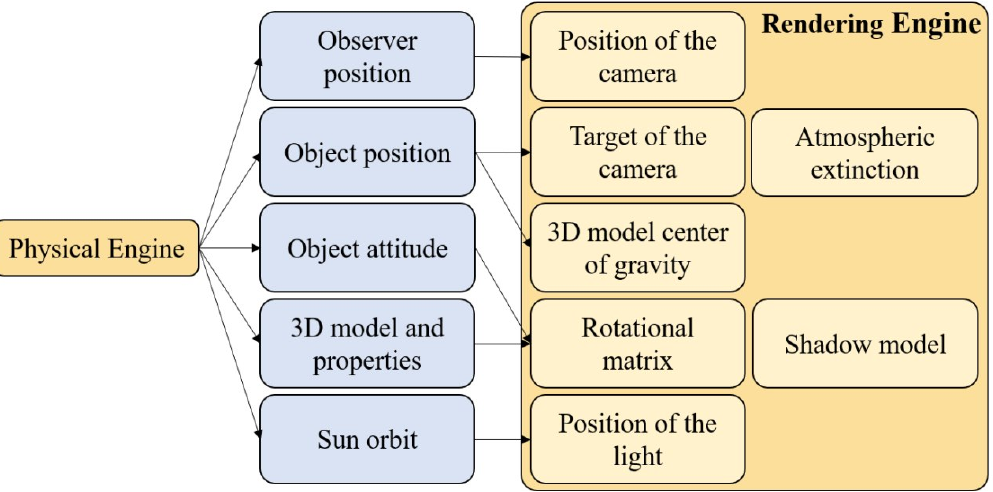
Figure 18. Rendering Engine—this engine takes care of computing, for each time step, the synthetic image of the object. The position of the observer is used as the position of the camera. The position of the object is used by the engine as the target of the barycenter of the 3D model to be rendered; the attitude of the object is then used to compute the rotation matrix of the model; finally, the position of the sun is used as the position of the light in the rendering engine.